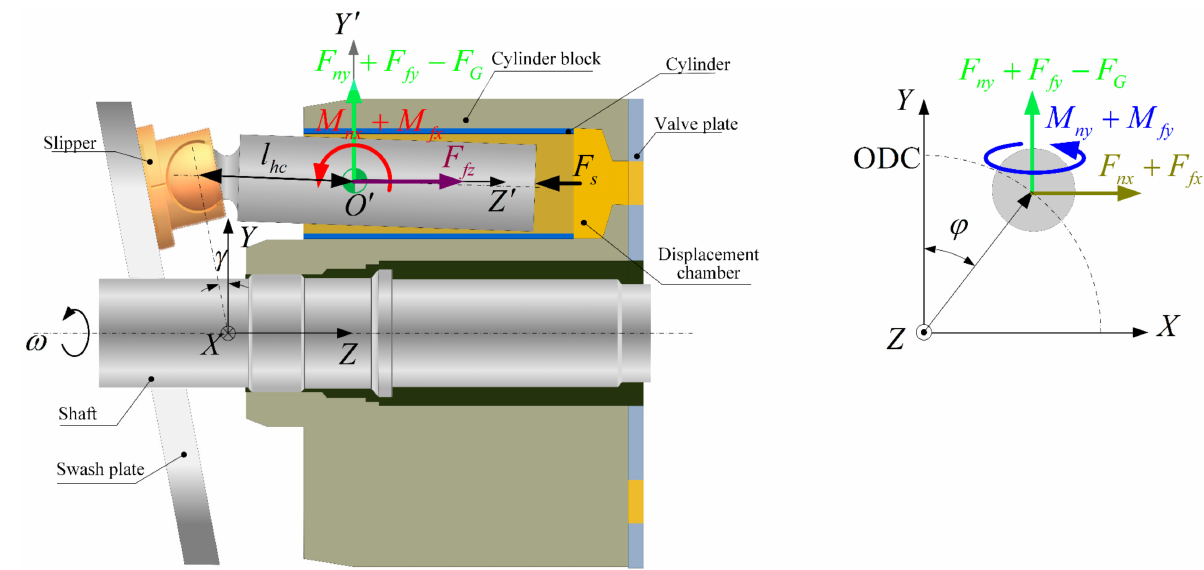
Figure 3. Typical structure of an axial piston pump, and forces and moment acting on the